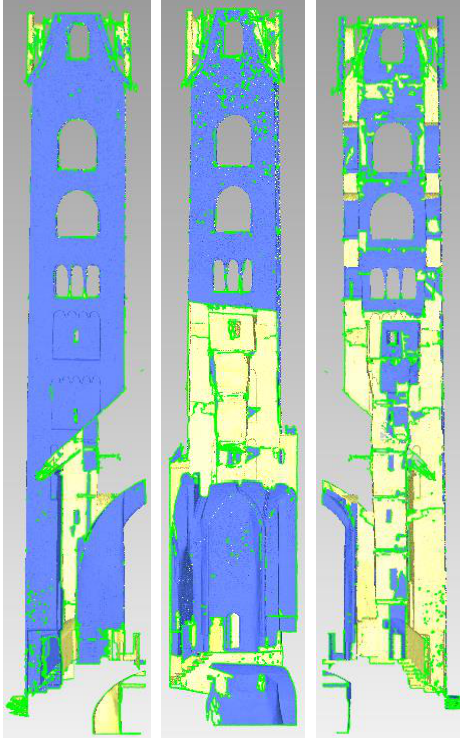
Figure 7. From left: Western, Southwestern and Southern fronts of the polygonal initial model. The green areas refer to non continuous surfaces (missing parts, cut elements etc...)